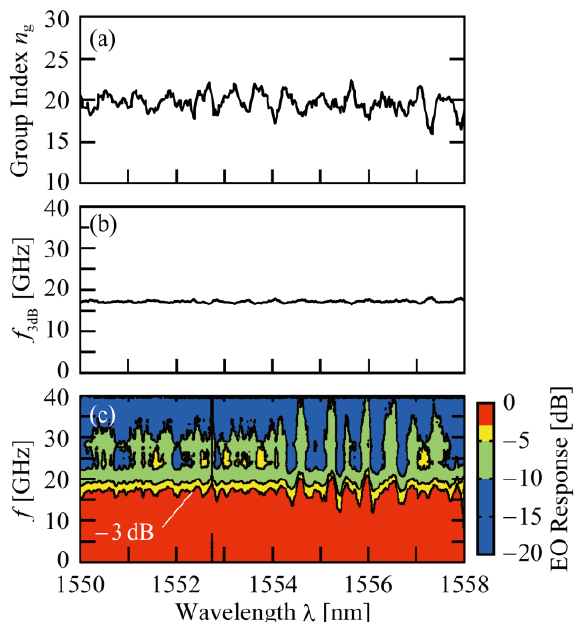
Figure 4. Fluctuations in frequency response over the wide wavelength range: ( a ) n g spectrum; ( b ) f 3dB spectrum calculated from Equations (2) and (3) with the measured n g and EE S 21 estimated with R = 96 Ω and C = 50 fF; ( c ) Frequency response spectrum R ( f , λ ) obtained from the averaged response at each λ , such as those represented by the black line in Figure 3b. The f 3dB is shown by the boundary between red and yellow regions. The fluctuation in the measurement setup was smaller than 1 GHz.